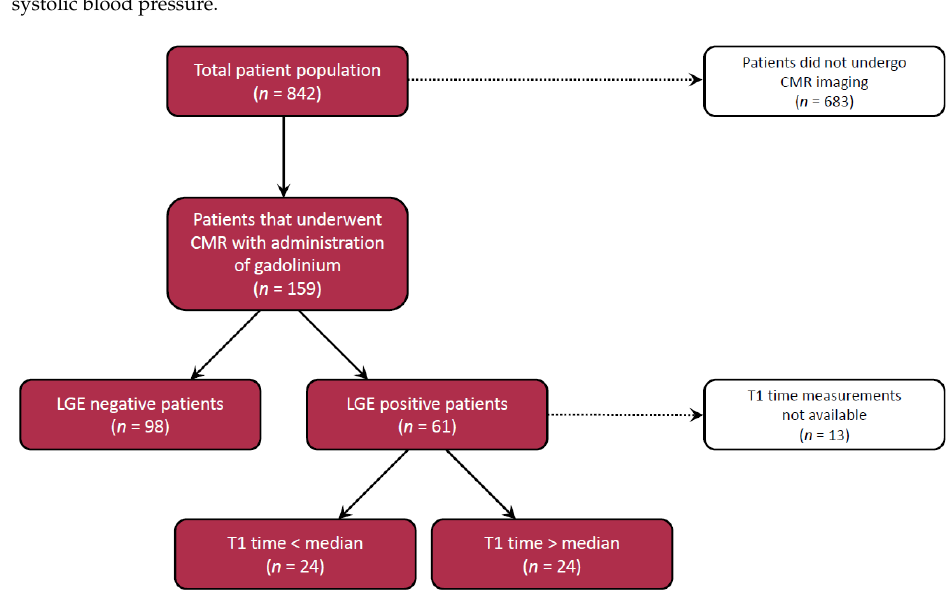
Figure 2. Patient selection flow chart.